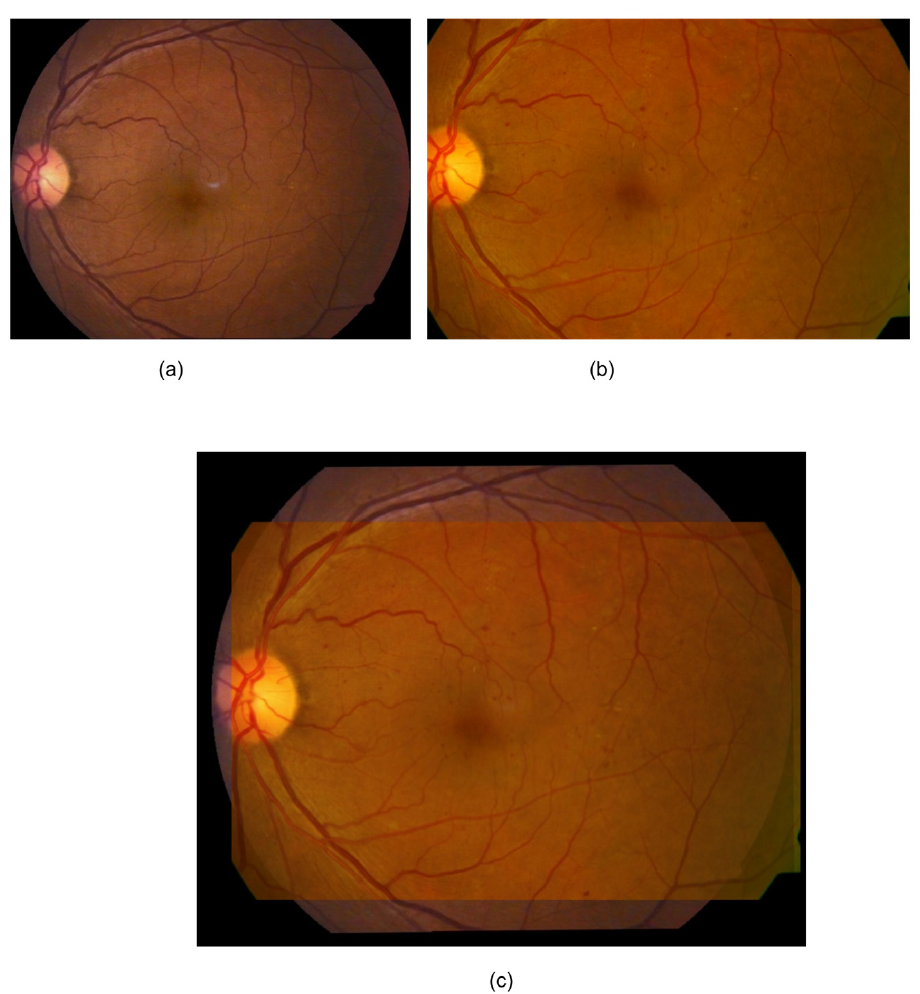
Figure 1. An example registration by Saha et al.’s method [23]. ( a ) Baseline image; ( b ) follow-up image; ( c ) mosaic image after registration. Only a fundus area that was common to both of the images was used for the analysis ( c